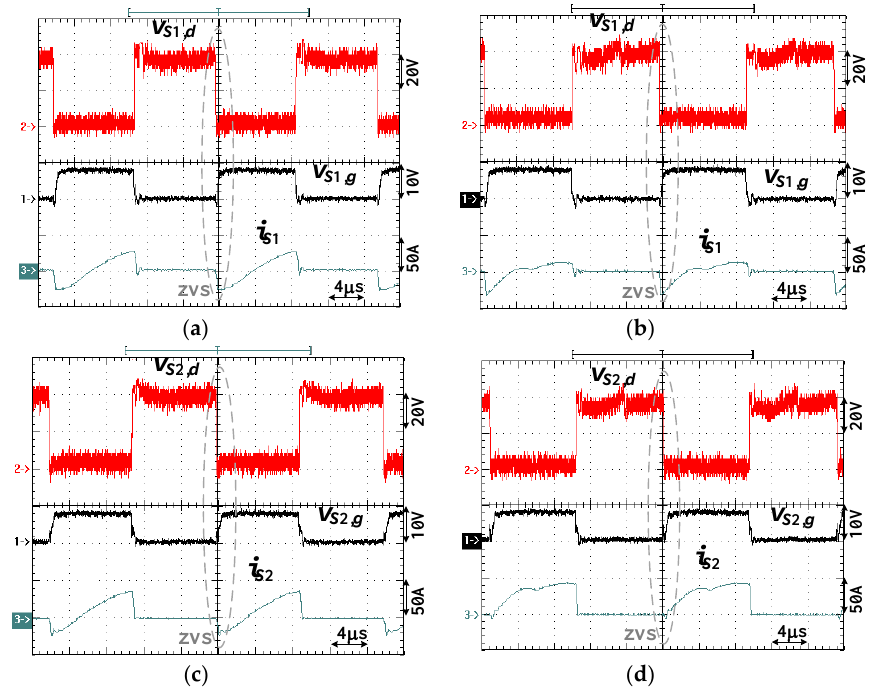
Figure 7. Experimental results of power switches S 1 and S 2 under low voltage mode operation and V in = 20 V: ( a ) v S 1 , g , v S 1 , d , i S 1 at 20% rated power; ( b ) v S 1 , g , v S 1 , d , i S 1 at 100% power; ( c ) v S 2 , g , v S 2 , d , i S 2 at 20% rated power; ( d ) v S 2 , g , v S 2 , d , i S 2 at 100% power.